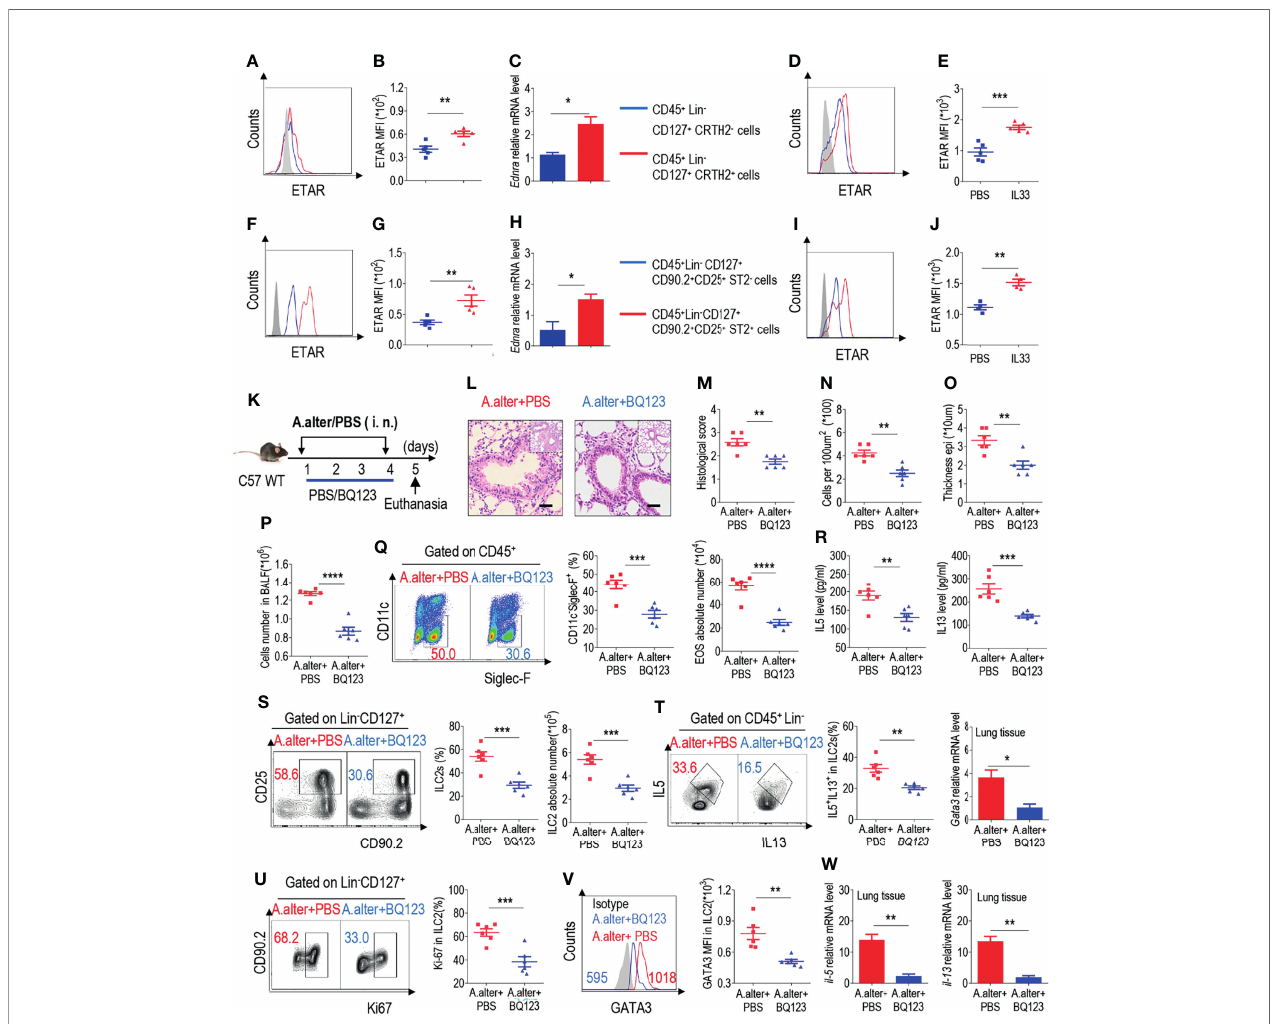
FIGURE 1 | BQ123 exhibited protective effects against Alternaria alternata-induced airway in fl ammation (A) Representative the mean fl uorescence intensity (MFI) from human ILC2s of ETAR-expressing CD45 + Lin - CD127 + CRTH2 - cells and CD45 + Lin - CD127 + CRTH2 + cells (n = 5). (B) Statistical analysis of ETAR expression. (C) mRNA expression levels of human endothelin receptor A ( Ednra ) were evaluated; b -actin level was used for normalization, and the lowest expression level in Ednra -negative cells was arti fi cially set to 1 (n = 3). Puri fi ed ILC2s from mouse lung and human PBMCs were cultured with rm/rh-IL-2, rm/rh-IL-7 and with or without rm/rh-IL-33 for 72 h. Then ETAR expression levels were analyzed by fl ow cytometry. Representative MFI (D, I) and statistical analysis (E, J) of ETAR expression were shown. (F) Representative results of fl ow cytometry MFI from mouse lung ILC2s of ETAR -expressing CD45 + Lin - CD127 + CD90.2 + CD25 + ST2 - cells and CD45 + Lin - CD127 + CD90.2 + CD25 + ST2 + cells(n=5). (G) Representativestatistical analysisof ETAR expression. (H) mRNA expression levels of mouse Ednra were evaluated; b - actin level was used for normalization,and the lowestexpression level in Ednra -negative cellswas arti fi cially set to 1 (n = 3). (K) Experimental scheme. FemaleC57BL/6J mice were intranasally challenged with A. alternata on days1 – 4 and were sacri fi ced 24 h after the last challenge onday 5. (L – O) Representative hematoxylin andeosin (H&E) staining of lungsections (L) and in fl ammation scores (M) , as well as the in fi ltratingcells (N) and airway epithelium thickness (O) were shown. Bars, 100 m m.Absolutenumber of BALF (P) , typical example of fl ow cytometry (left) andstatistical results (right) both population andthe absolute numbersof EOS in the bronchoalveolar lavage fl uid (BALF) (Q) were indicated. (R) IL-5 and IL-13 levelsin BALFwere determined. (S – V) Representative results of fl ow cytometry, statistical analysis of the frequencies of ILC2s and absolute counts (S) , IL-5 + IL-13 + ILC2s (T) , Ki67 + ILC2s (U) , and levelsofGATA3 (V) inthe lungs were shown. (W) The mRNA expression levelsof ILC2-relatedtarget genes inlungtissues, including Il5 , Il13 , and Gata3 , were evaluated; b -actin level was used for normalization,and the lowest expression level inthe A. alternata + BQ123 groupwas arti fi cially set to 1 (n = 3).Data are representative of two or three independent experiments (n= 6 for the A. alternata + PBS group; n = 6 for the A. alternata + BQ123 group). *P < 0.05; **P < 0.01; ***P < 0.001; ****P < 0.0001. In allpanels, individual results and mean ± standard errorofthe mean (SEM) are shown;statisticalsigni fi cance was determined using a two-tailed unpaired Student ’ s t-test (B, C,E,G, H, J, M – U,W) or Mann-Whitney test (V)